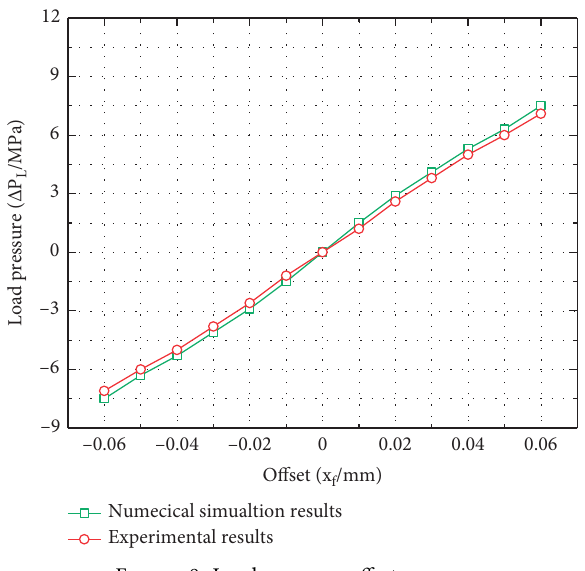
Figure 8: Load pressure-offset curves.